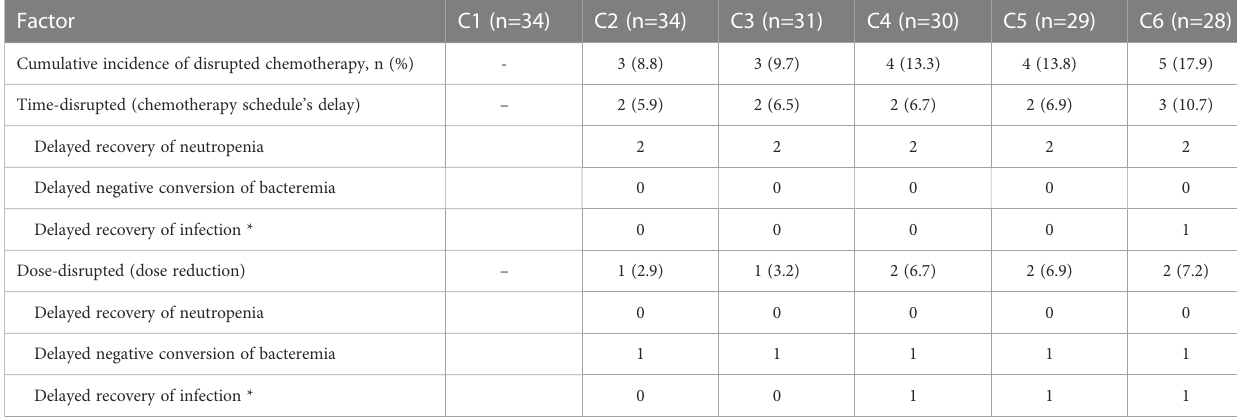
TABLE 3 Clinical causes of ‘ Disrupted chemotherapy ’